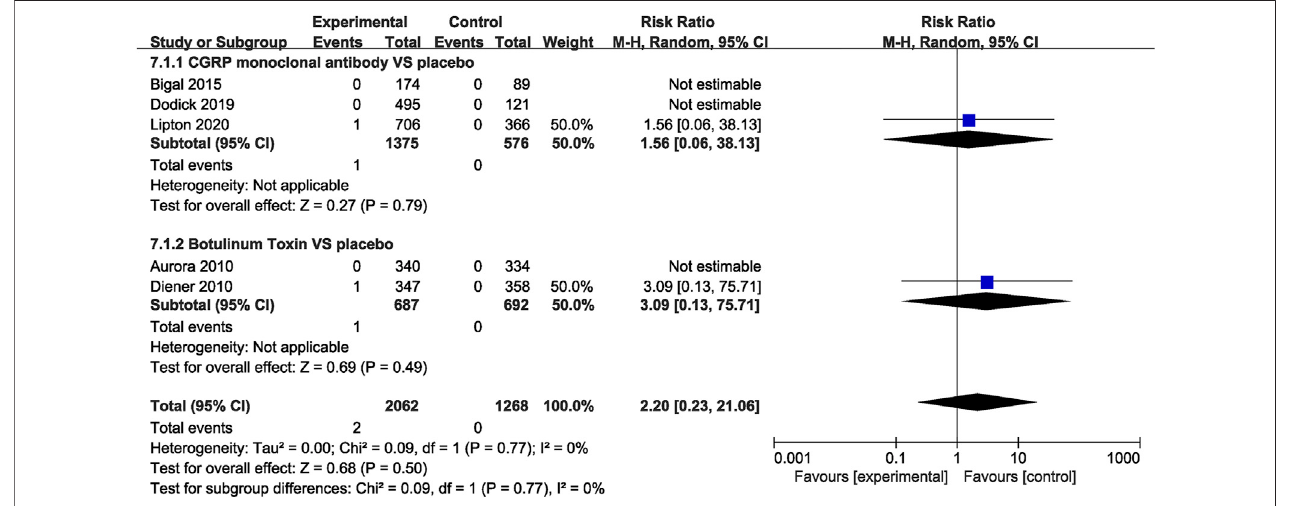
FIGURE 9 | Pooled treatment – related serious AEs ’ relative risk in CGRP monoclonal antibody and botulinum toxin.